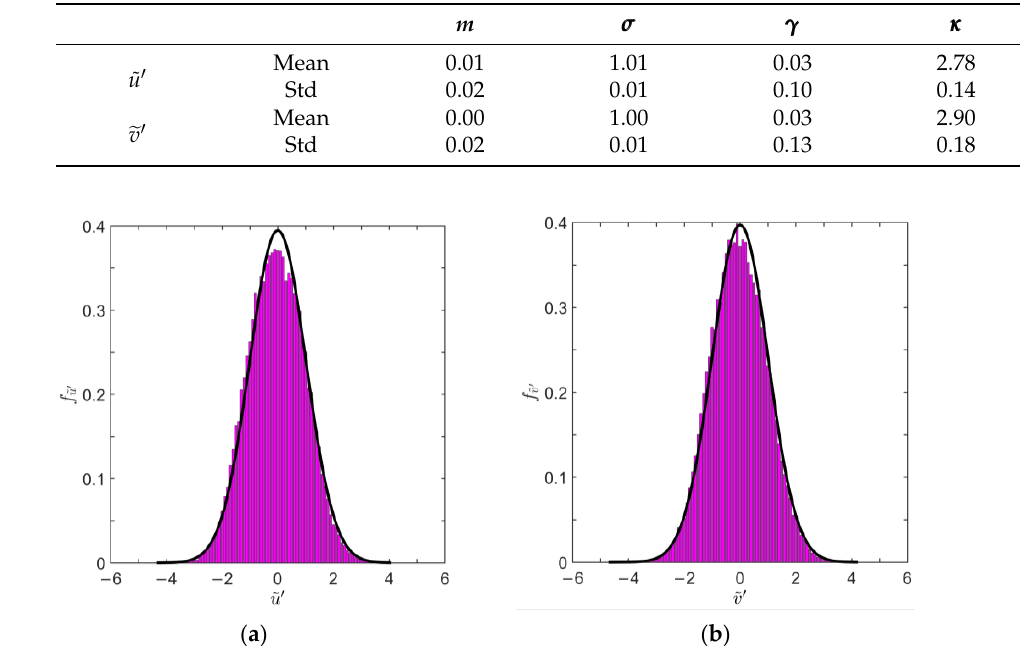
Figure 10. Probability density function of longitudinal ( a ) and lateral ( b ) reduced turbulent fluctuation and the corresponding Gaussian distribution.